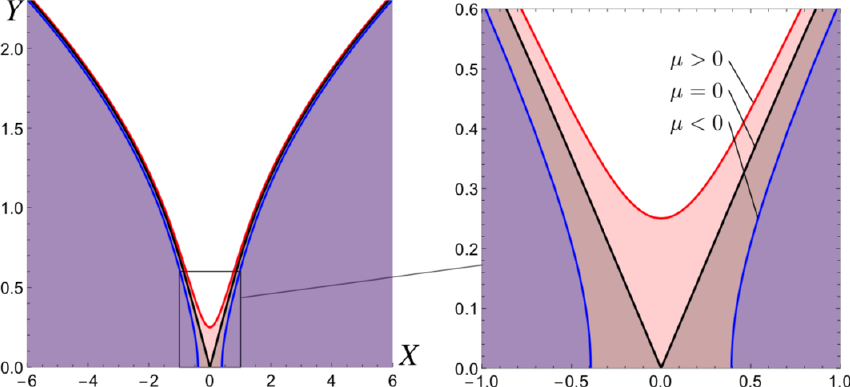
Figure 2 . Geometry of the horizon near the merger transition as obtained in this article (cf. eqs. (4.27) and (4.28)). The black curve is the critical solution ( (cid:22) = 0), the blue curve the localized black hole ( (cid:22) = (cid:0) 1 = 16), the red curve the nonuniform black string ( (cid:22) = 1 = 16). At short distances the singular cones are smoothed (split or fused) for (cid:22) 6 = 0. At large distances all these geometries deviate from the conical shape to connect to localized black hole and highly non-uniform black string horizons; both of these can be regarded, away from the conical region, as slightly de- formed Schwarzschild black holes. The proper physical size of the magni(cid:12)ed conical region (right) p (cid:16) (cid:17) D along the vertical is O (1 =D ) along the horizontal axis and O 1 =